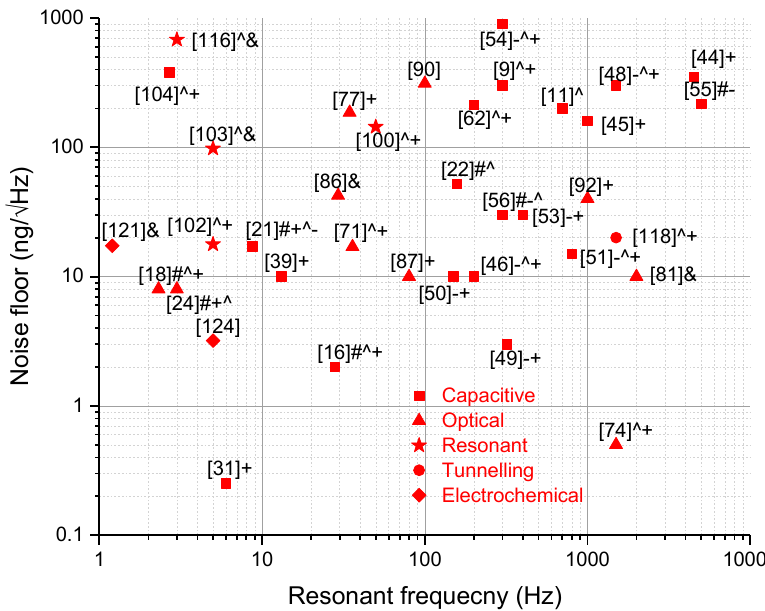
√ Hz noise floor. “ + ” refers √ Hz noise